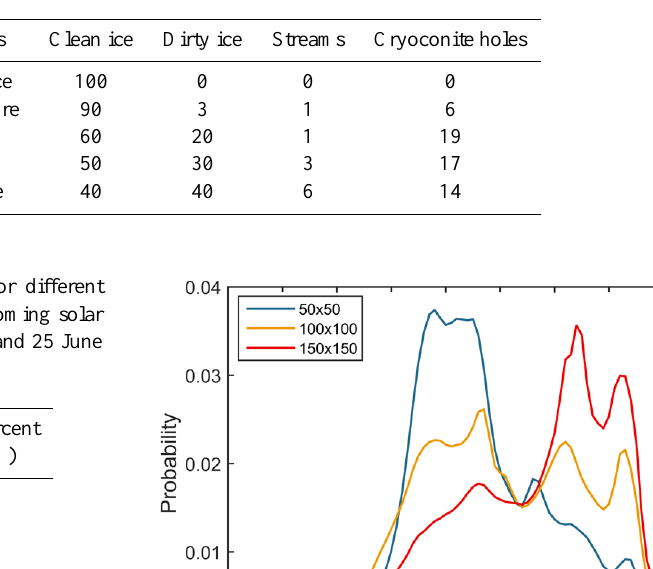
Table 3. Seasonal evolution (%) of four surface types at five distinct time steps approximated from Chandler et al. (2015).